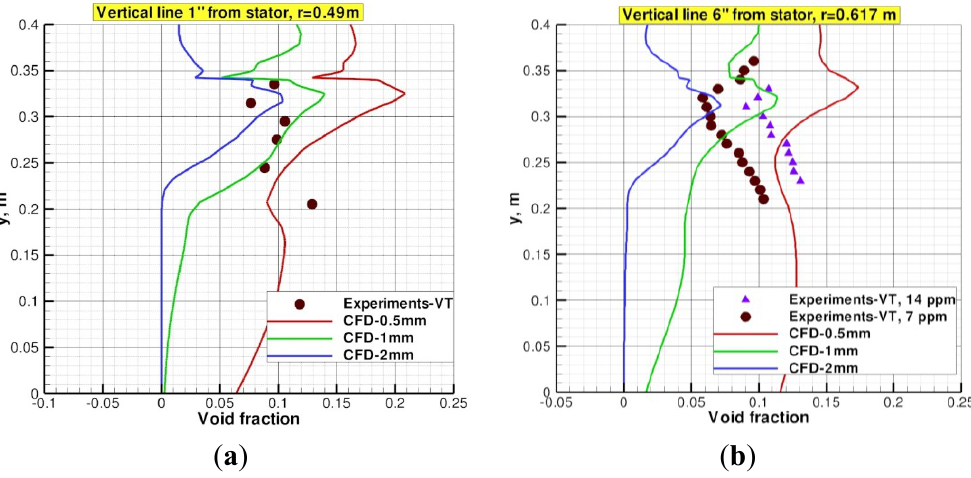
Figure 7. ( a ) Air volume fraction (α) profile at 25.4 mm downstream of stator and ( b ) air volume fraction (α) profile at 152.4 mm downstream of